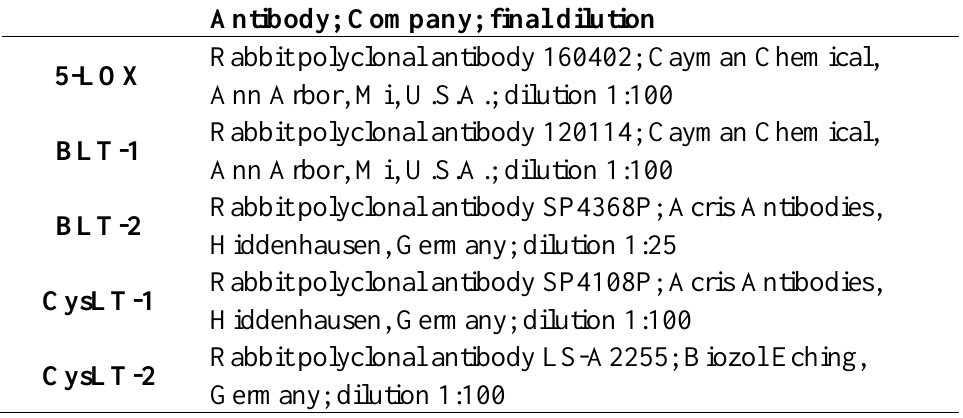
Table 3. Characteristics of antibodies for immunohistochemical